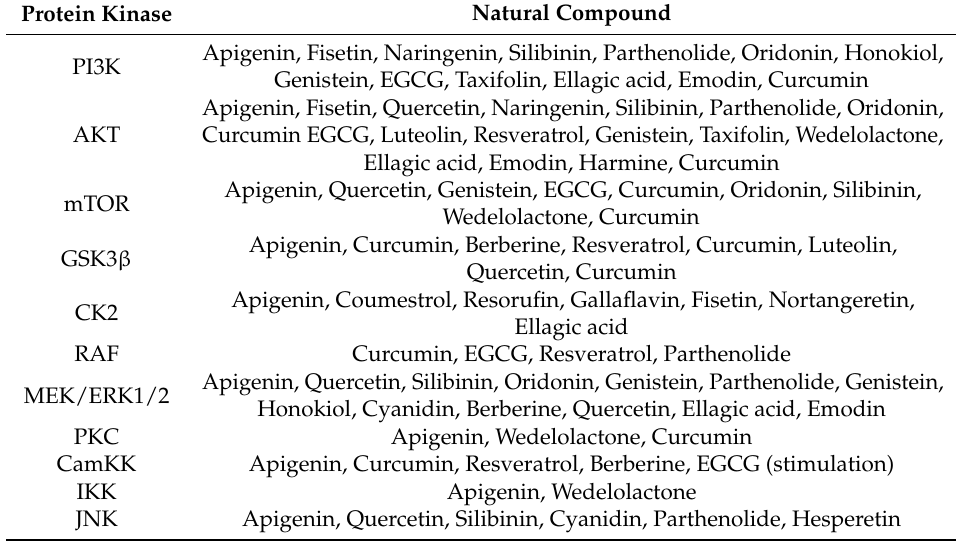
Table 2. Selection of serine/threonine-specific kinases (STKs) shown to be inhibited by natural